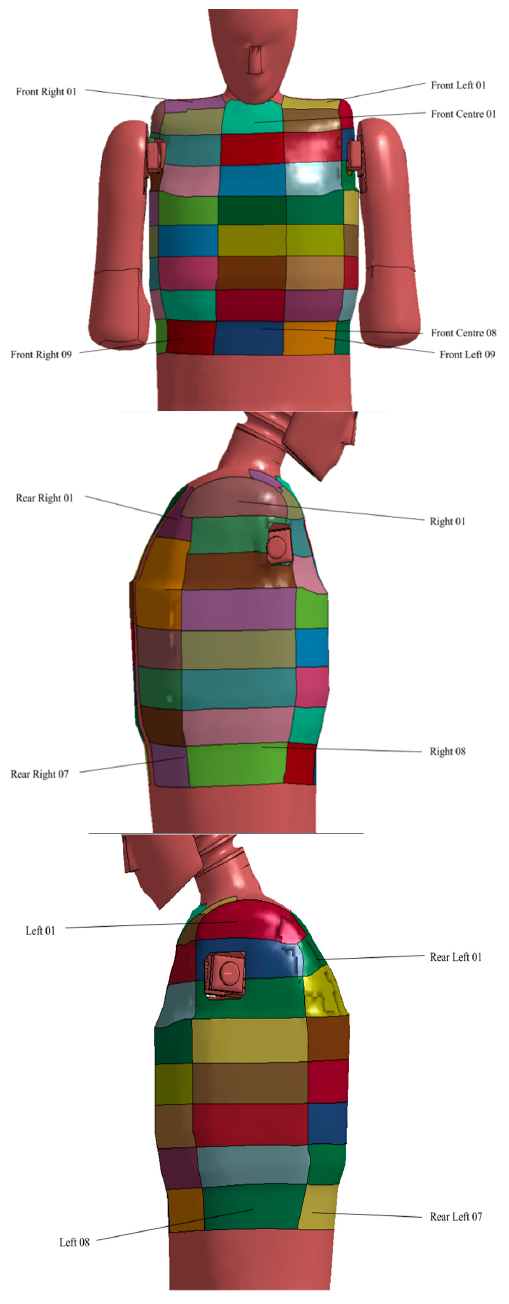
Figure 3. Thorax divided into segments for force measurements. Only the top and bottom segments are titled. Segments were numbered sequentially starting from “01” at the